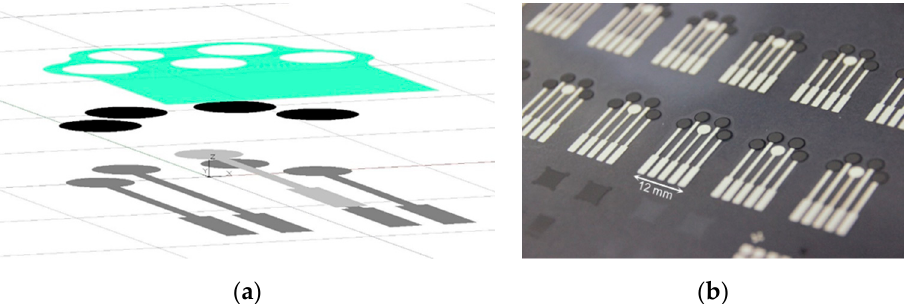
Figure 1. ( a ) Explosion view of screen-printed chloride sensor depicting the layers. (i) Silver (dark grey), (ii) silver/silver chloride (light grey), (iii) carbon (black), and (iv) insulation/encapsulation (green). ( b ) Manufactured sample sheet of sensors before deposition of the selective and reference membranes. Table 1. Membrane compounds of the chloride-selective membrane using the chloride ionophore I – cocktail A with its corresponding portion in parentheses.